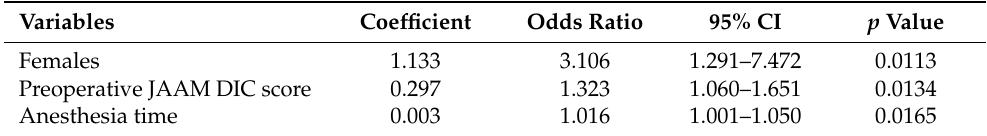
Table 6. Multiple logistic regression analysis on the incidence of